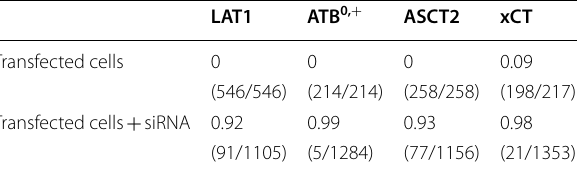
Table 2 Knockdown efficiency at the protein